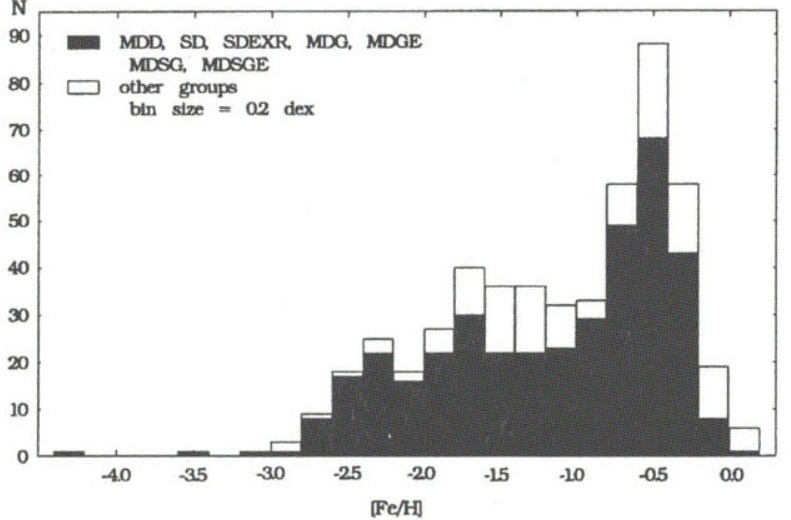
Fig. 1. Distribution of standard stars by